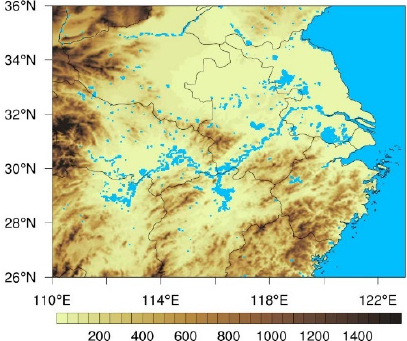
Figure 1. Area of study with topographical elevation (m) in color.